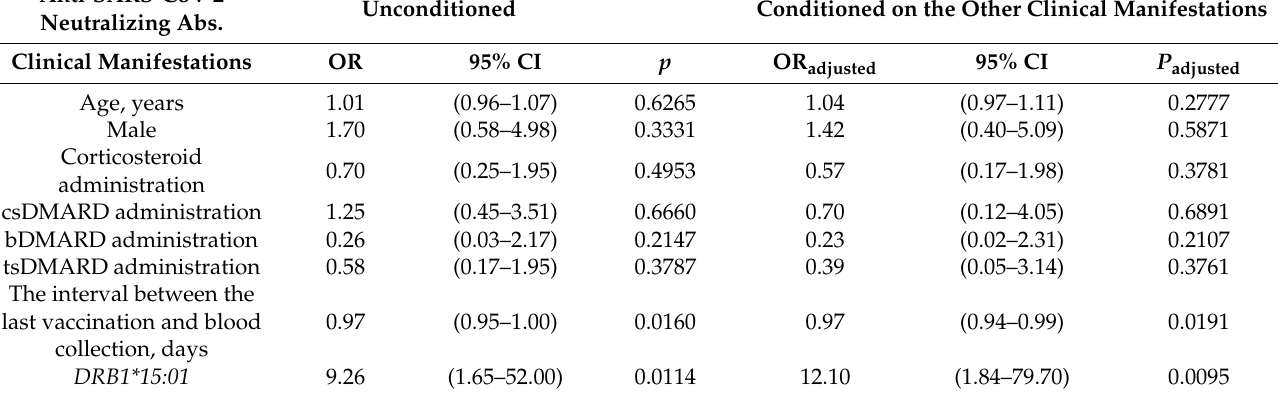
Table 7. Multiple logistic regression analysis of DRB1*15:01 and clinical manifestations: impact on anti-SARS-CoV-2 neutralizing